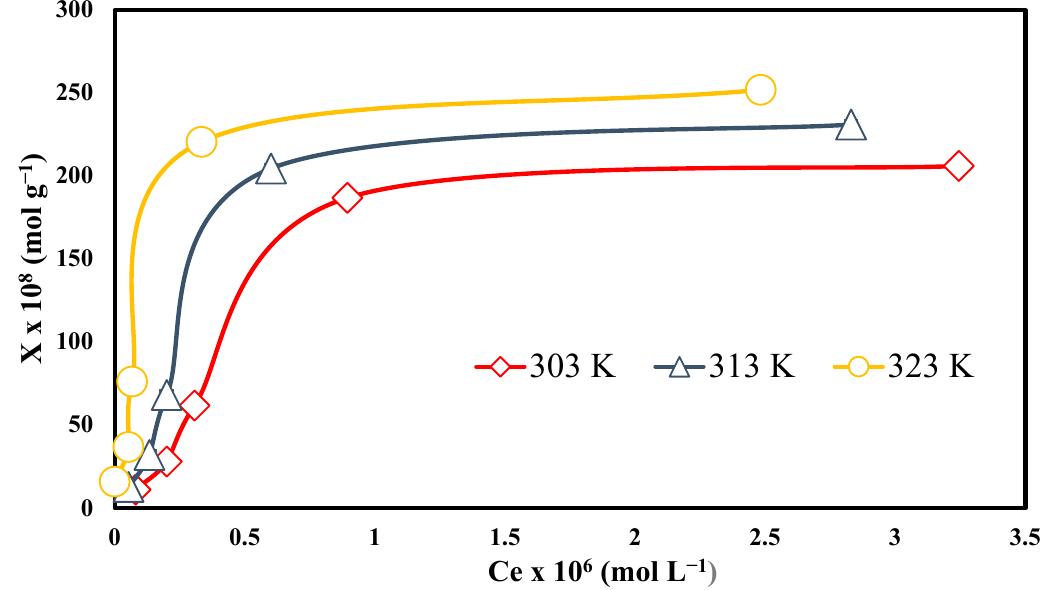
Figure 8. Effect of temperature and concentration on arsenate adsorption onto MgO-IBC composite at pH 5.